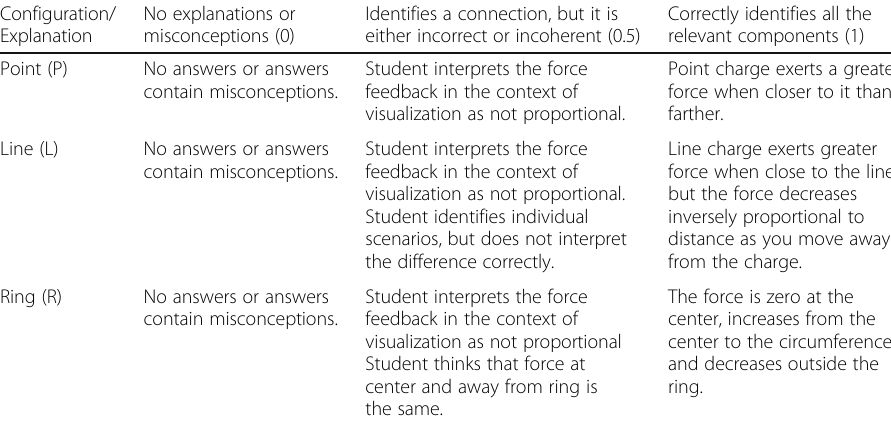
Table 2 Scoring rubric for the Force feedback interpretation questions Configuration/